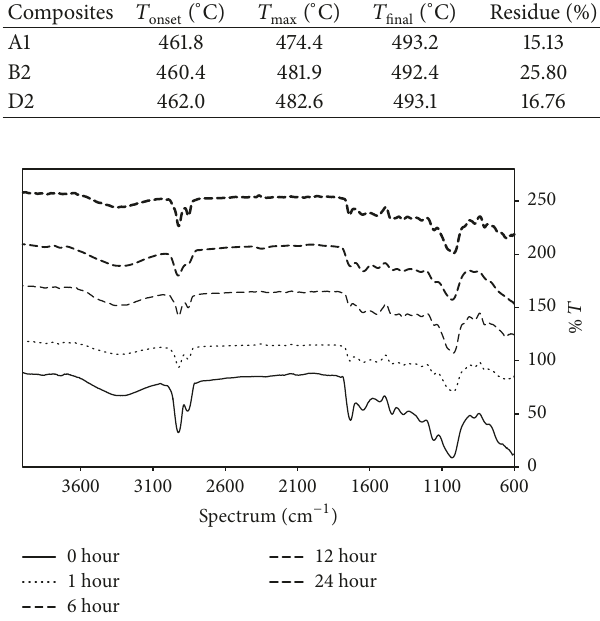
Figure 1: FTIR spectra of different time of 1% NaOH treated